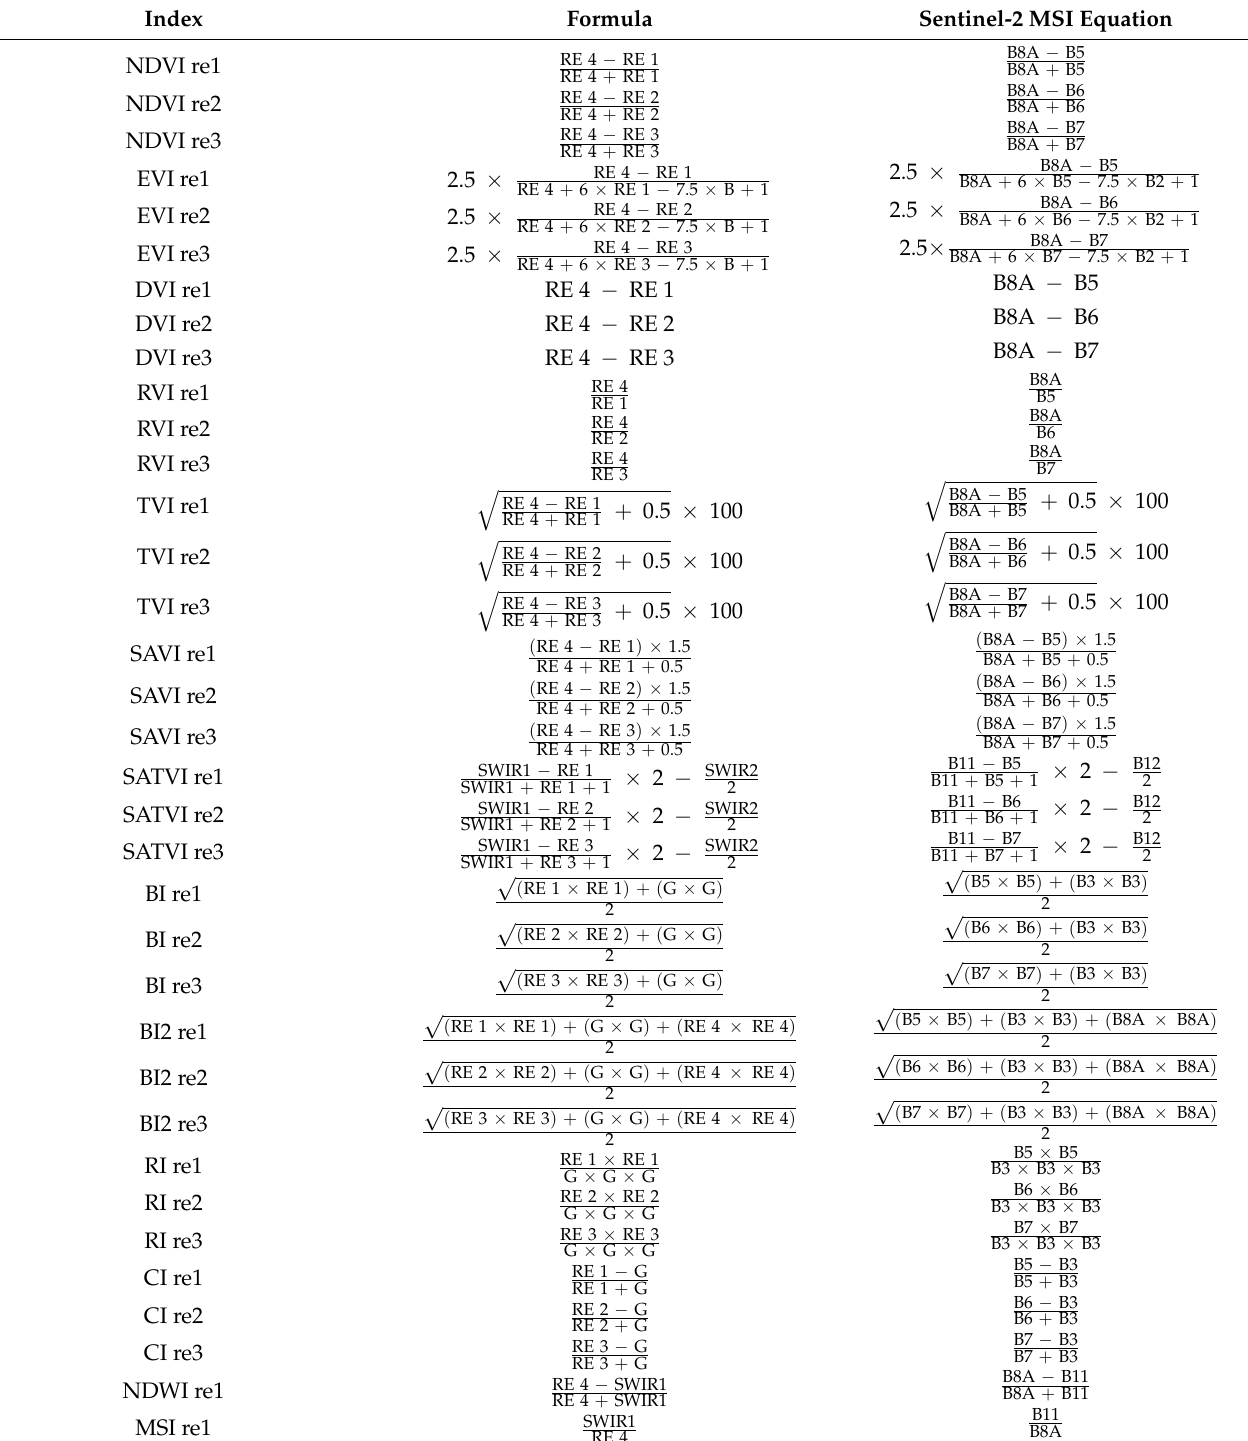
Table 4. The newly proposed red-edge spectral